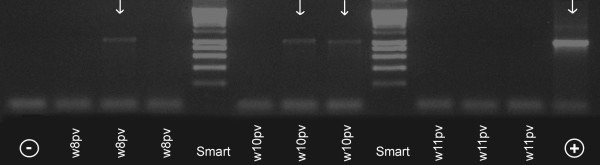
PCR detection of the plasmid DNA in muscle tissue of vaccinated turkeys. Gel image representing the PCR-products, obtained by PCR on DNA extracted from muscle tissue at 8, 10 and 11 weeks p.v. (w8pv, w10pv and w11pv). The 3 different samples of the same date, visible on the gel, are 3 DNA extractions from the pooled stock of muscle tissue at the (presumed) injection site, on which the PCR was conducted. The arrows indicate where a band of 1084 bp is visible. The SmartLadder (Eurogentec) was used as molecular size marker (with bands of 200, 400, 600, 800, 1000, 1500, 2000, 2500, 3000, 4000, 5000, 6000, 8000 and 10000 bp). DNA of non-vaccinated muscle tissue was used as a negative control (-) and the pcDNA1::MOMP vector as a positive control (+). At 8 weeks p.v., a band of 1084 bp could still be detected in 1 out of 3 DNA isolates and at 10 weeks p.v. in 2 out of 3 DNA isolates. At 11 weeks p.v. no band could be detected on the ethidium bromide stained gel.